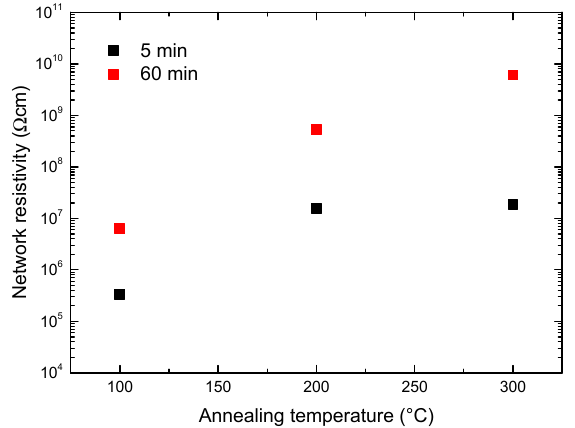
Figure 7. Network resistivity as a function of the annealing temperature in the sample grown for 5 (black squares) and for 60 minutes (red squares).